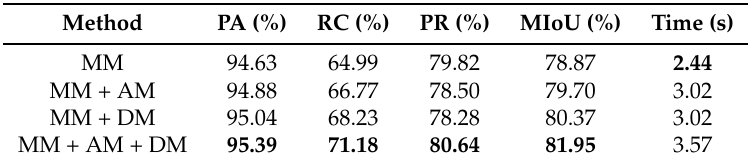
Table 3. Ablation experiment of TCDNet (bold represents the best result).